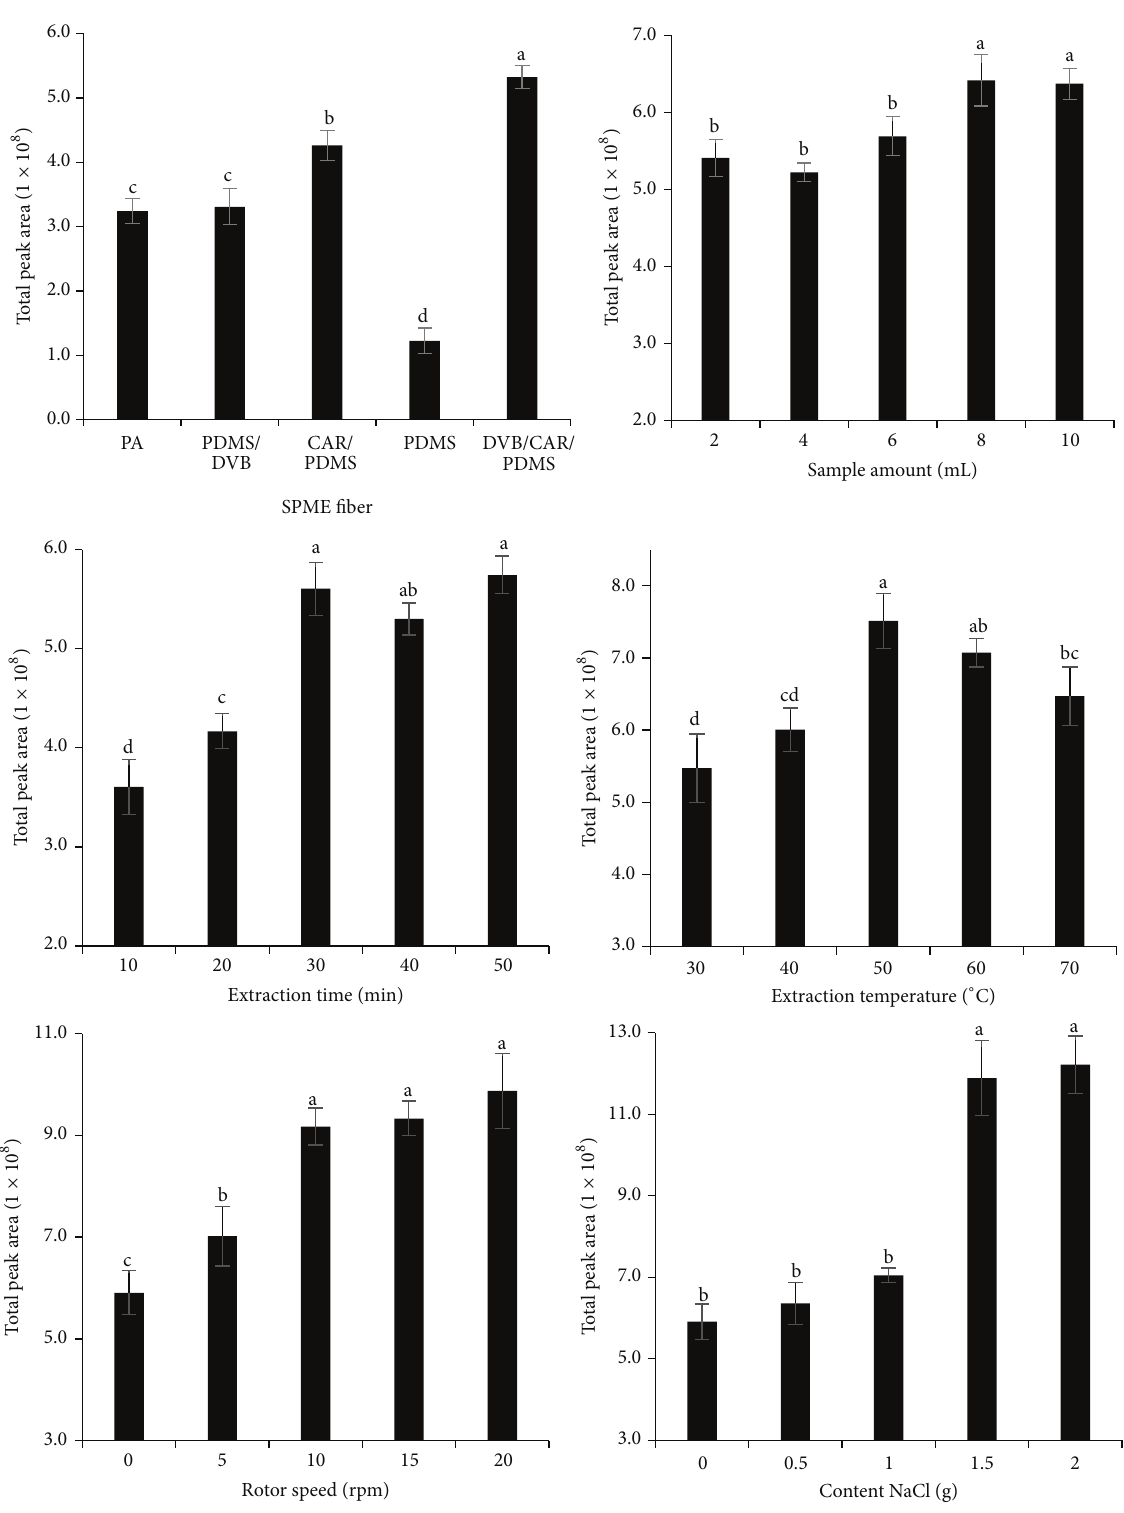
Figure 1: Optimization of HS-SPME. Effect of fibers, sample amount, extraction time, extraction temperature, rotor speed, and content NaCl. Bars with different letters have significantly different ( 𝑝 < 0.05 ) mean